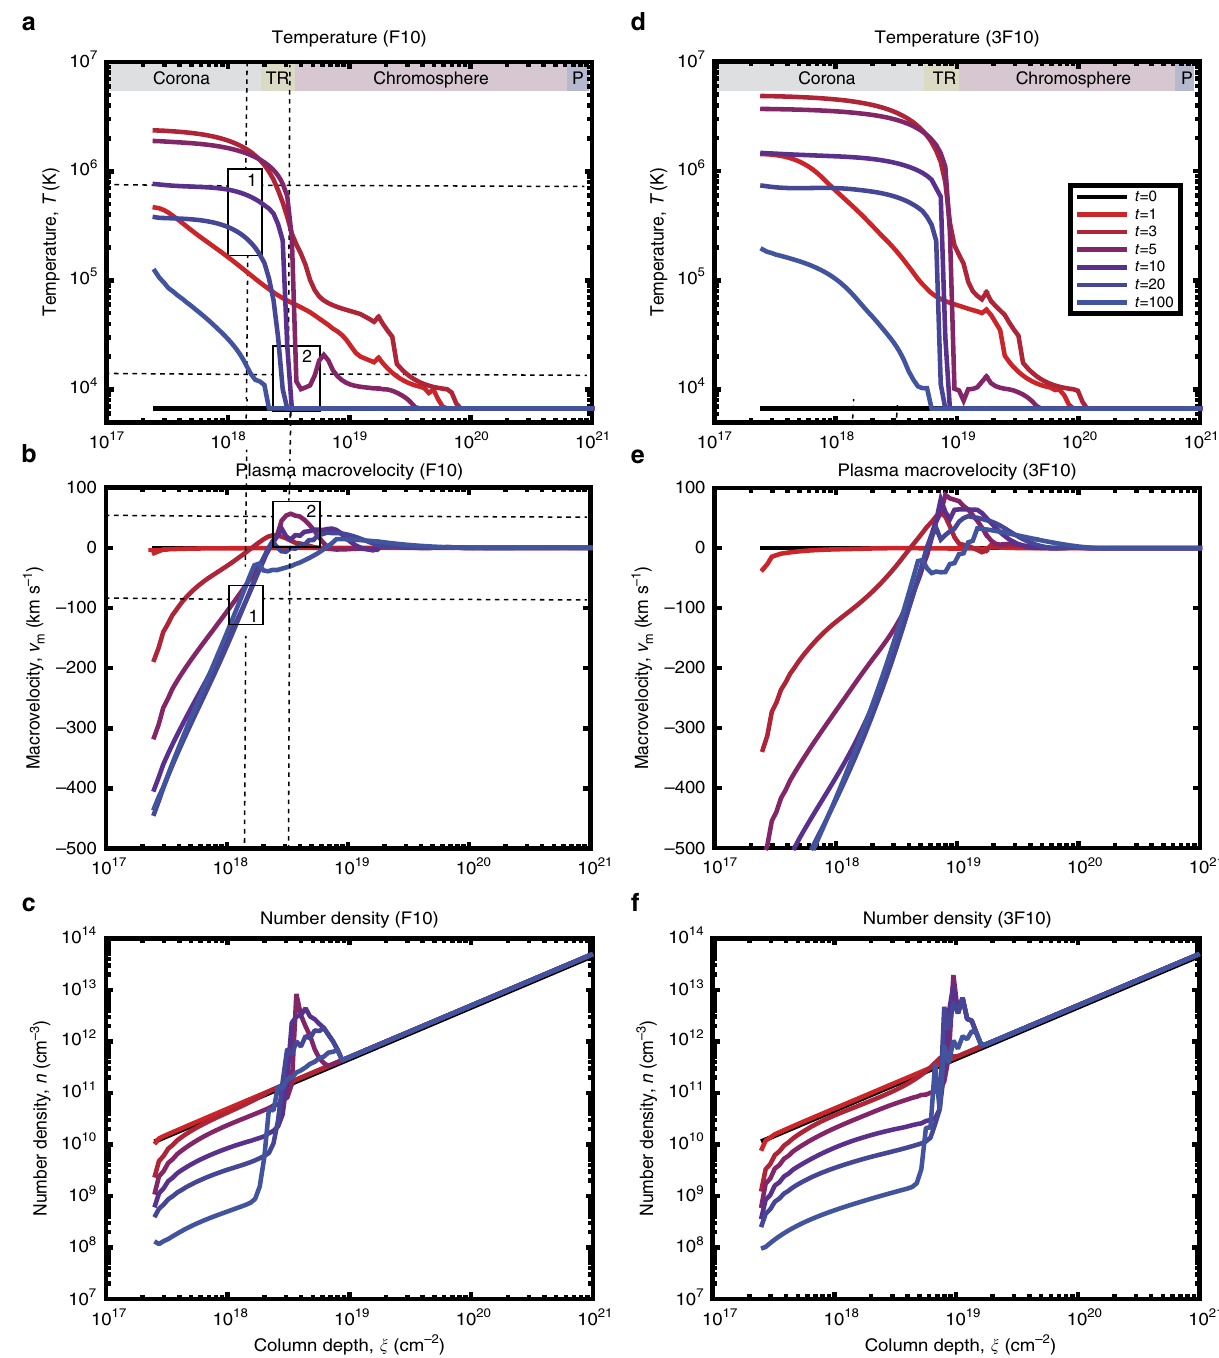
Figure 4 | Simulated hydrodynamic responses. The simulated hydrodynamic responses of a flaring atmosphere to injection of a beam with the initial flux of 10 10 ergcm (cid:2) 2 s (cid:2) 1 (F10 model, left panels) and 3 (cid:3) 10 10 ergcm (cid:2) 2 s (cid:2) 1 (3F10 model, right panels) following Zharkova and Zharkov 23 showing column depth dependencies of: ( a , d )—the electron kinetic temperature, K, ( b , e )—the plasma macrovelocity, kms (cid:2) 1 and ( c , f )—the plasma number density, cm (cid:2) 3 forming a flaring corona, chromosphere and photosphere (see the text for more